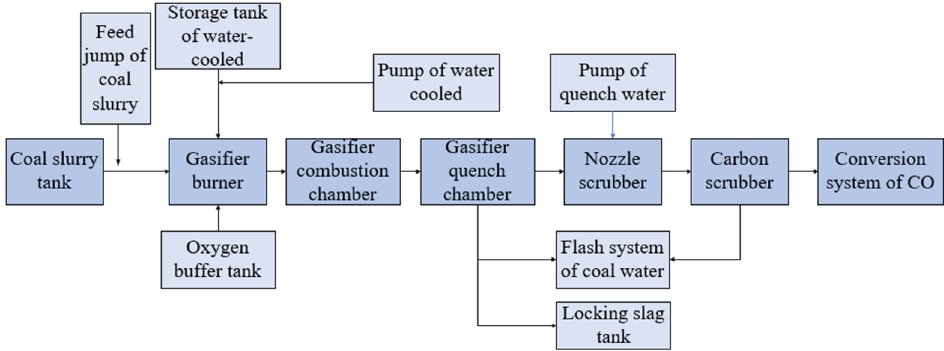
Figure 6. Flow chart of the coal-gasification system.